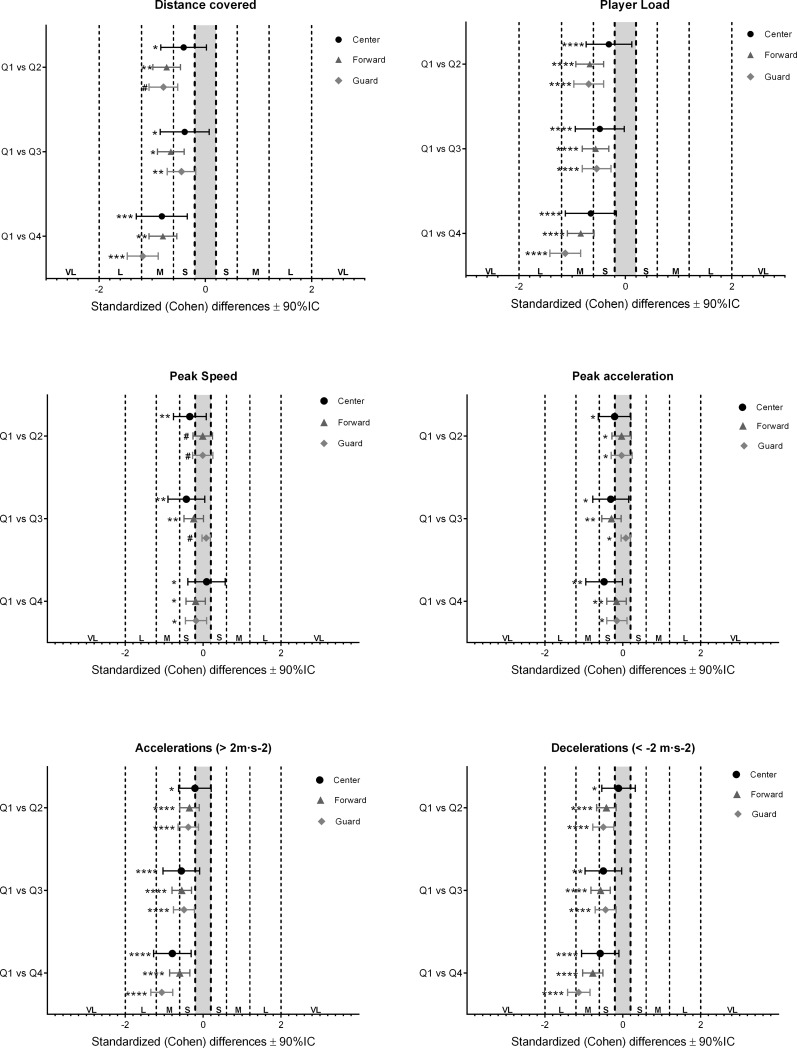
Standardized differences (Cohen’s d) in variables according to the 3 positions and game quarter.Error bars indicate uncertainty in the true mean changes with 90% CI. #: very unlikely; *: unlikely; **: possible; ***: likely; ****: very likely; *****: almost certainly. VL: Very Large; L: Large; M: Moderate; S: Small.